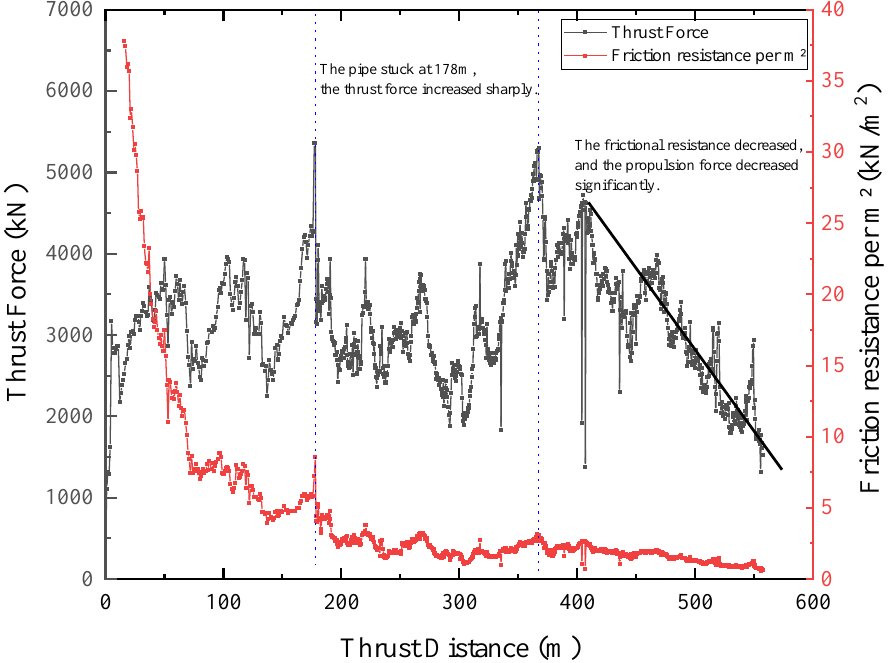
Figure 15. The thrust force of the construction.